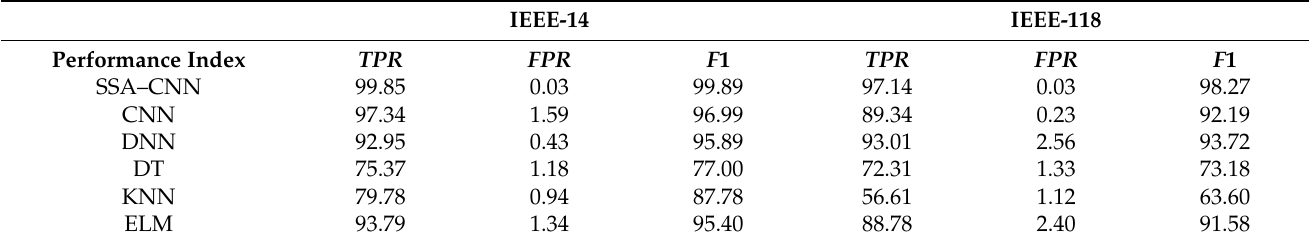
Table 4. Simulation results of the different